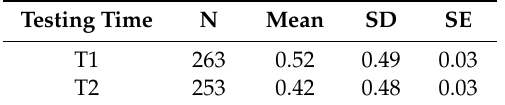
Table 13. Mean Accuracy with respect to Testing Time for L3 German.